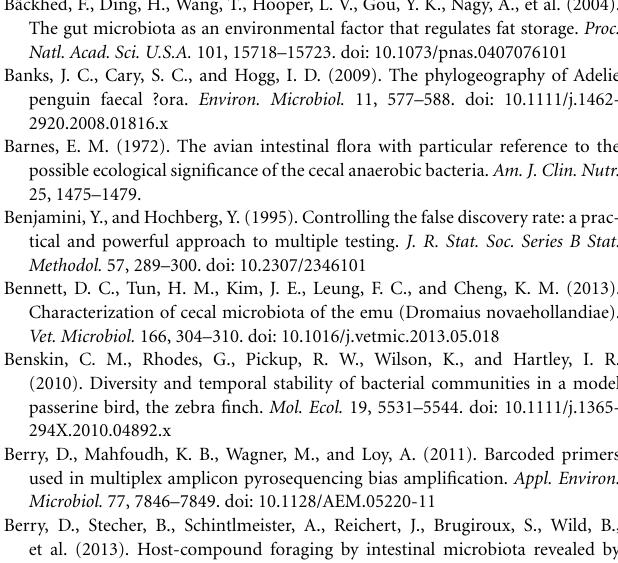
sample site (top right), diet (bottom left), and captivity status (bottom right). Note that the “herbivore” grouping represents exclusively